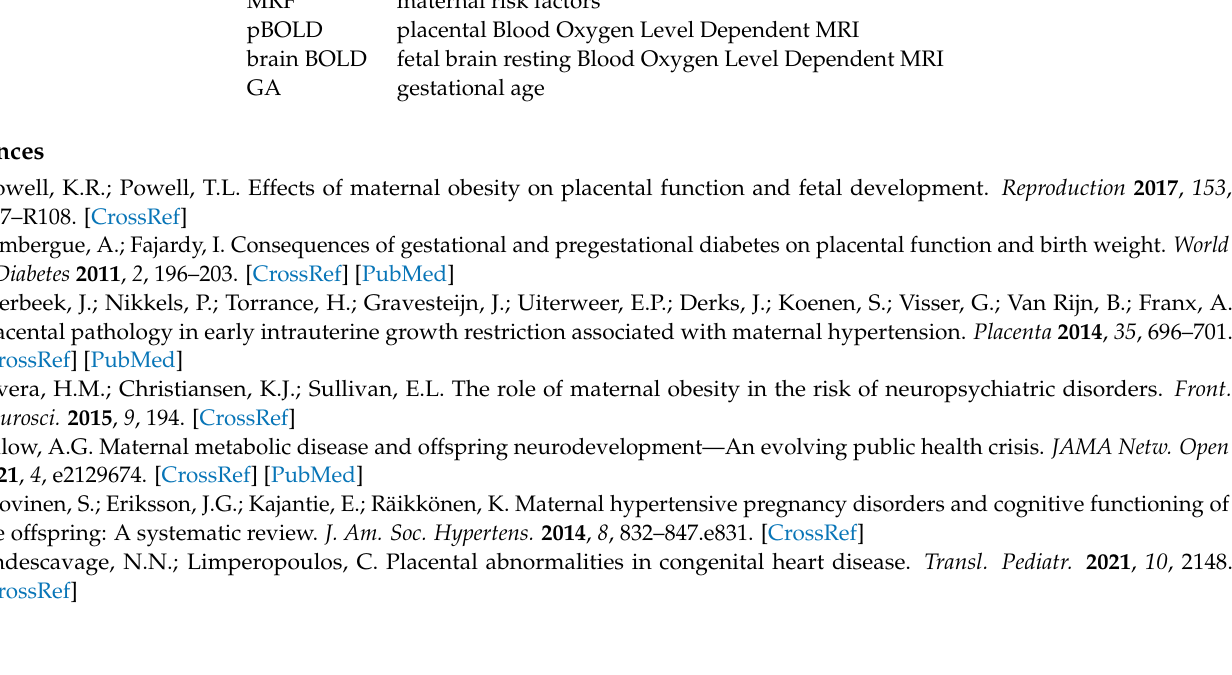
CHD and CHD group; Table S1A: Pregnancy and Delivery Characteristics; Table S1B: Pregnancy and Delivery Characteristics in Relation to Placental Findings; Table S2: Comparison of Placental Pathology between CHD and Non-CHD Groups; Supplemental